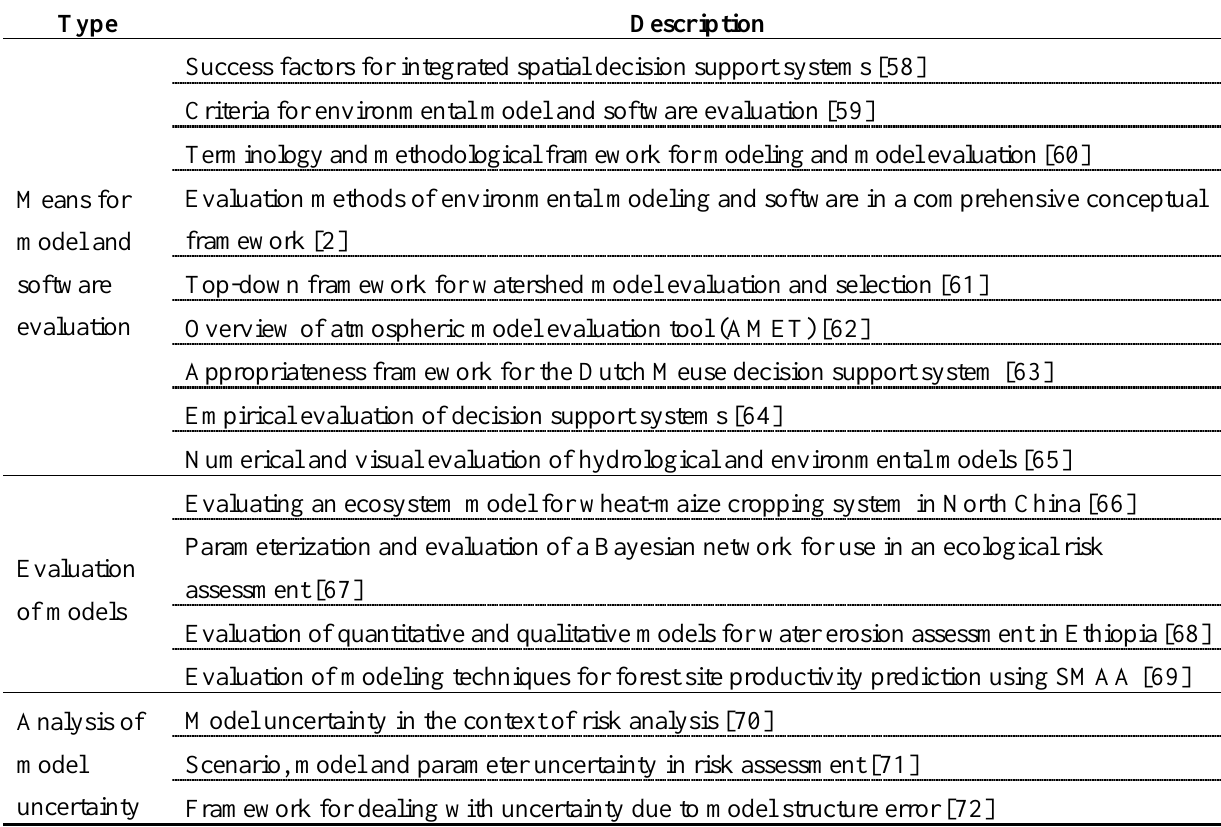
Table 3. Examples of technical assessment of models perspective to assessment and model